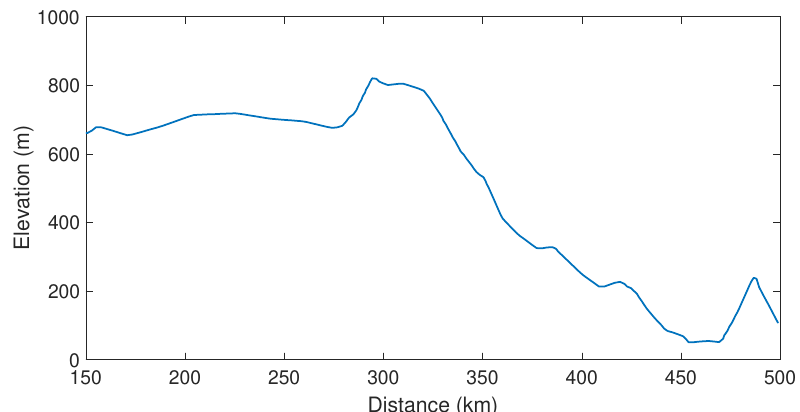
Figure 9. Elevation profile digitized from [21] under CC BY 4.0 license.